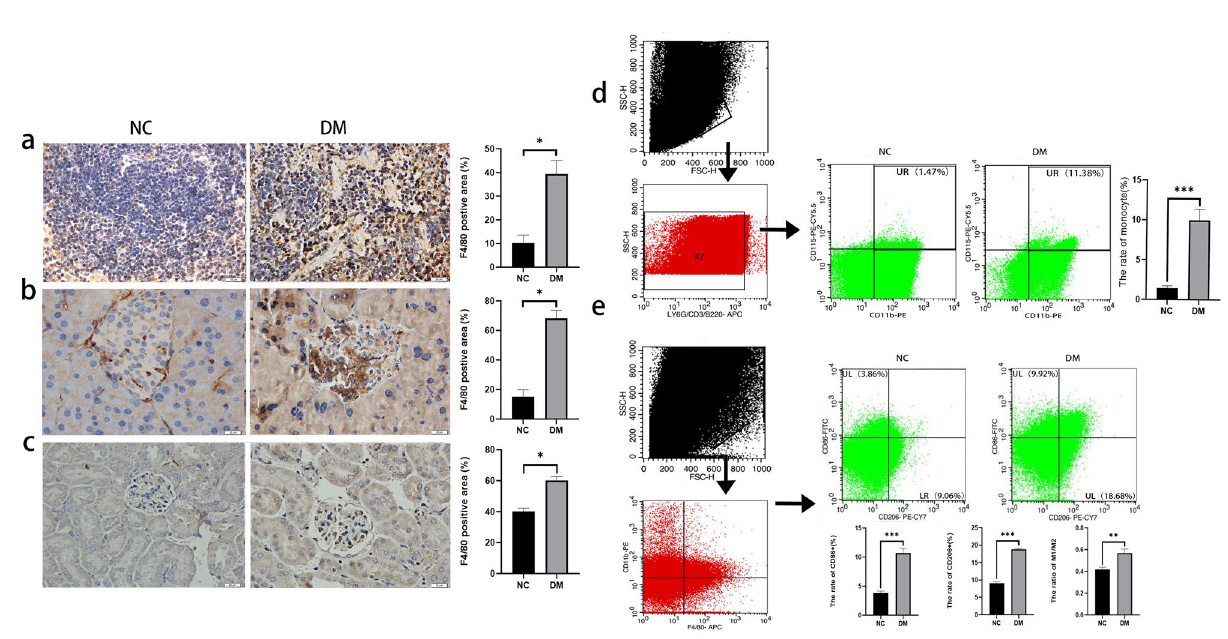
Figure 3. The change of the macrophages in different organs. F4/80-positive cells were detected by Immunohistochemical staining in different organs and their positive area was evaluated, spleen ( a ), pancreas ( b ), kidney ( c ). Changes in the proportion of monocytes (Ly6G – , CD3 – , B220 – and CD11b + , CD115 + ) in the spleen of each group was determined by Flow cytometry ( d ). Changes in the proportion of macrophage (CD11b + and F4/80 + ) and its subtypes (M1(CD86 + ) and M2(CD206 + )) in the kidney of each group was determined by Flow cytometry ( e ). Scale Bar = 20 μm, * P < 0.05, ** P < 0.01, *** P < 0.001. NC, normal control; DM, diabetes